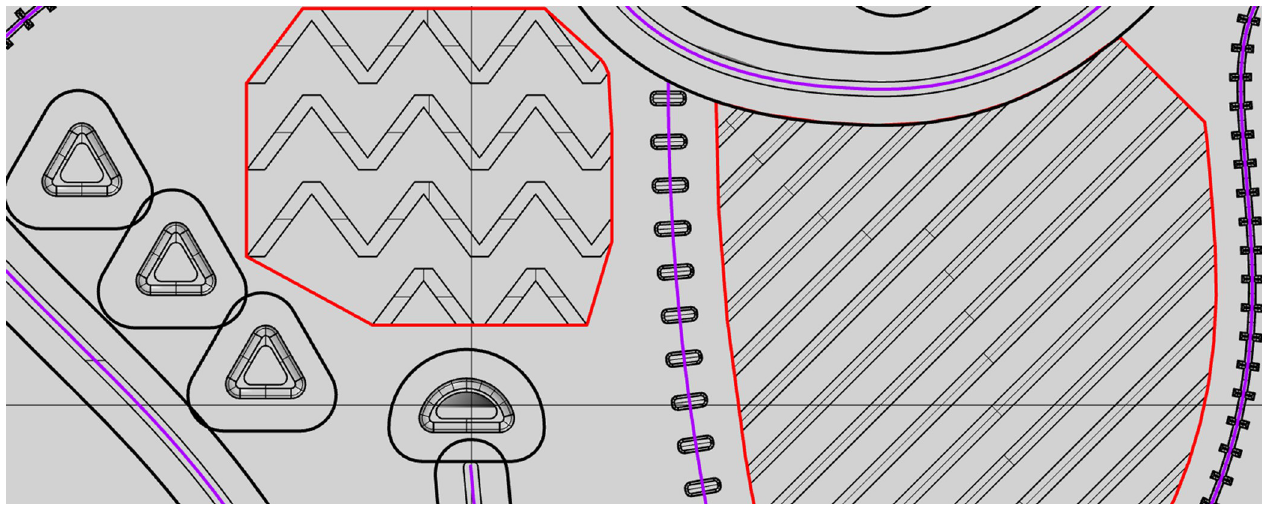
Fig 10. Vectors used for calculation of information value. Lines’ axes are marked in purple, area symbols’ outlines in red.